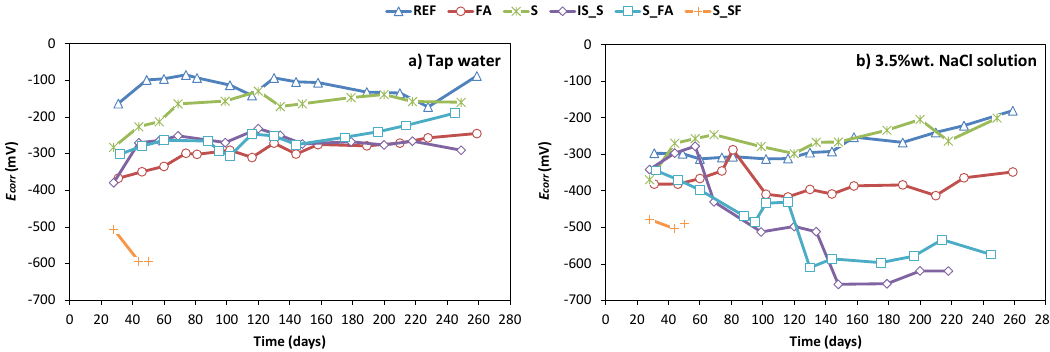
Figure 6. Open-circuit potential of steel embedded in mortar immersed in ( a ) tap water and ( b ) NaCl 3.5 wt.% solution, with 7 days of curing prior to immersion or exposure.